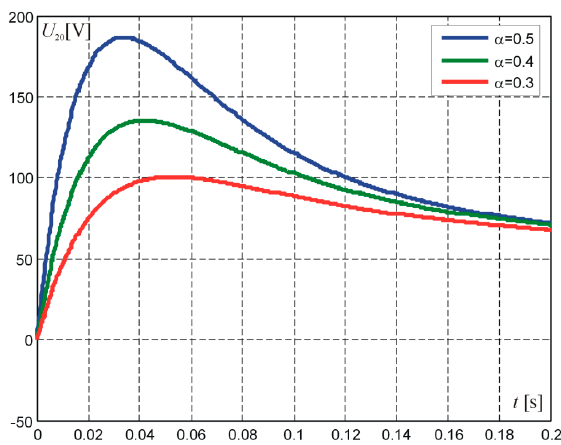
Figure 11. Voltage curves at the output of a two ‐ port network with rectangular ‐ pulse forcing for α = 0.5, 0.4, 0.3.